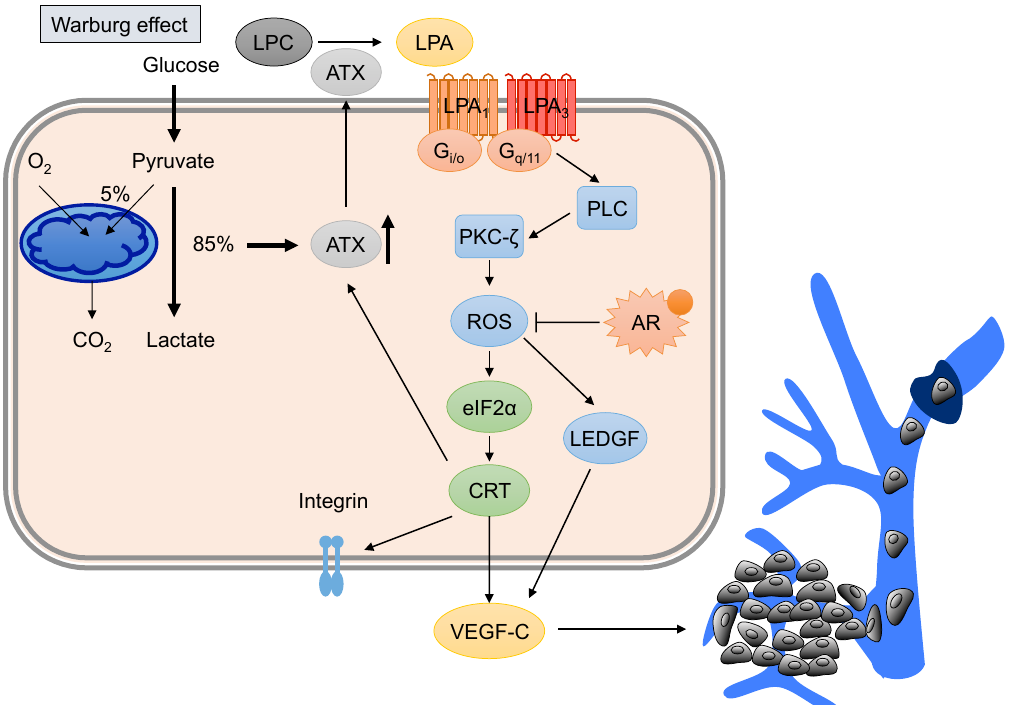
Figure 3. LPA–VEGF-C signaling in prostate cancer (PCa). Advanced PCa tumor cells utilize